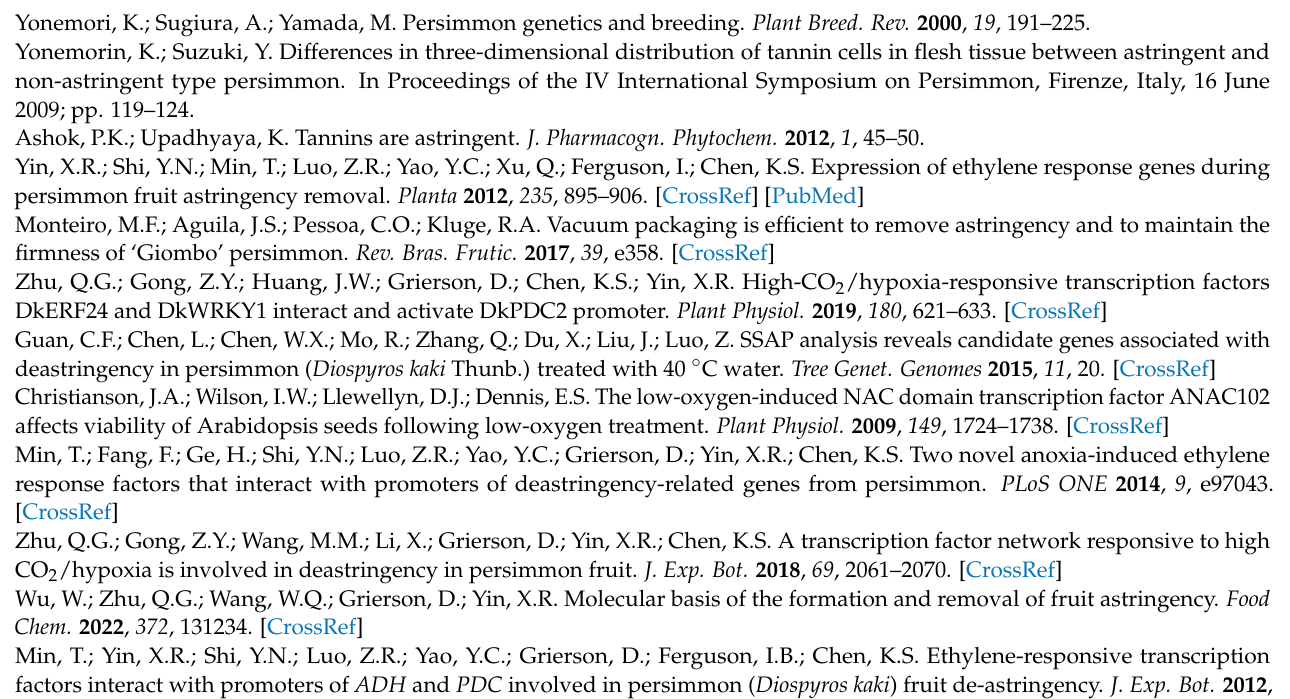
Table S2: Primers used for real-time PCR analysis; Table S3: Primers used for pGEX-4T-1 vector construction; Table S4: Sequences of the probes used for